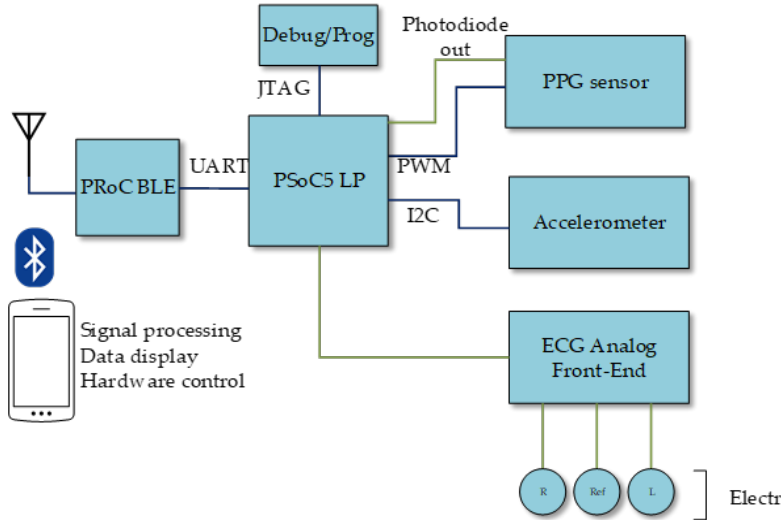
Figure 1. Conceptual schematic of the prototype. PSoC = Programmable System on Chip; BLE = Bluetooth Low-Energy; PPG = photoplethysmography; ECG = electrocardiography; PWM = Pulse Width Modulation; UART = Universal Asynchronous Receiver Transceiver; JTAG = Joint Test Action